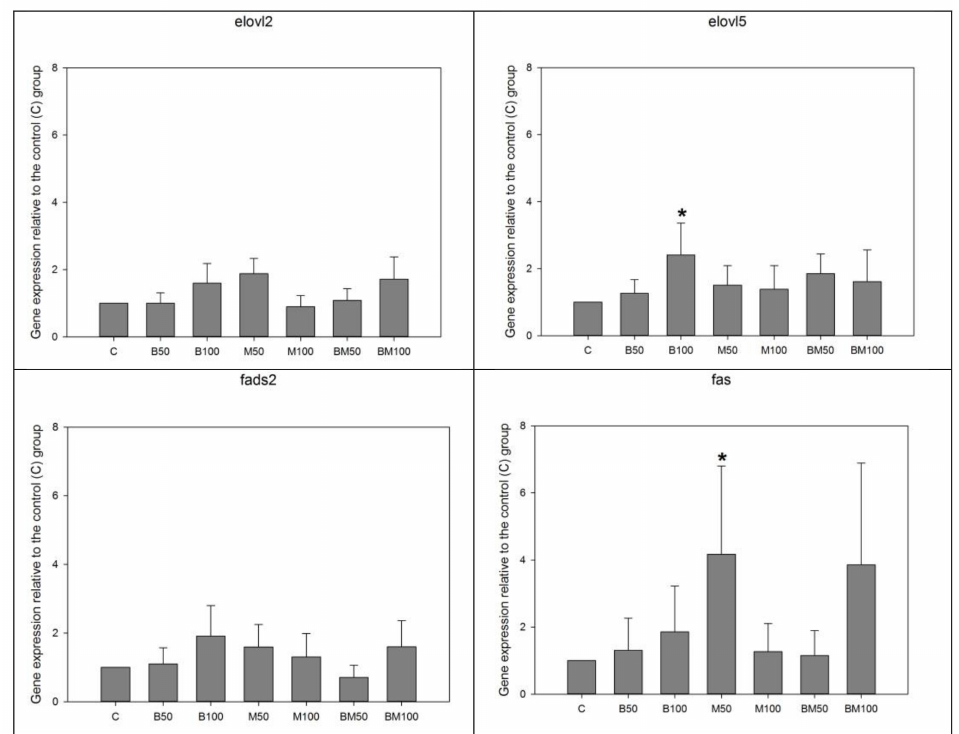
Figure 4. Nutritional regulation of fatty acyl desaturase ( fads2 ), fatty acyl elongases 2 ( elovl2 ) and 5 ( elovl5) , and fatty acid synthase ( fas ) in liver of African catfish grower fed a control diet and six different experimental diets. Values are normalized expression ratios relative to the control (C) diet. *: significant ( p < 0.05) difference compared to the control (C)